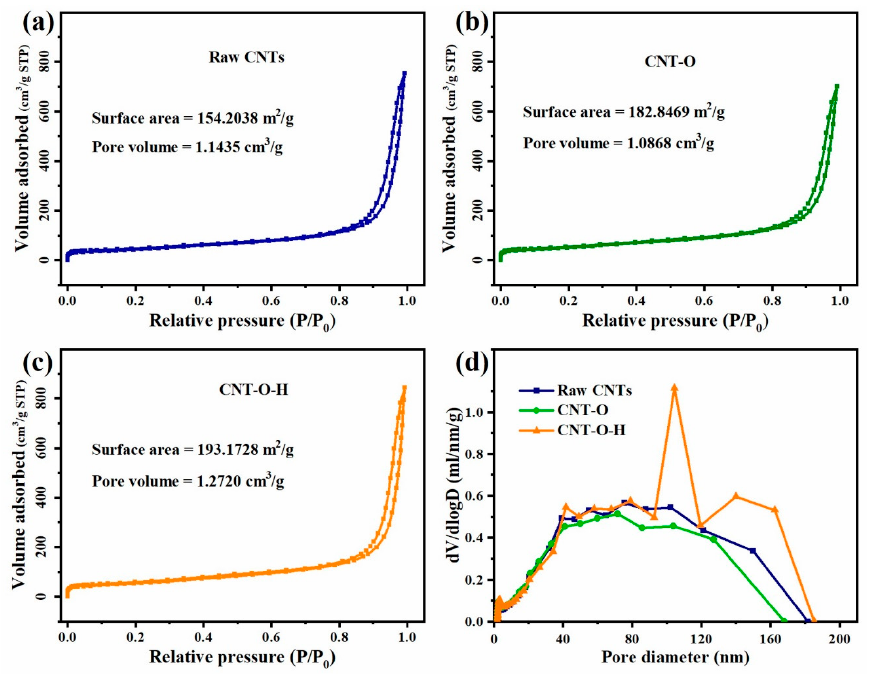
Figure 3. N 2 adsorption-desorption isotherms of raw CNTs ( a ), CNT-O ( b ), CNT-O-H ( c ), and pore size distributions ( d ). Nanomaterials 2023 , 13 , x FOR PEER REVIEW Further, XPS was employed to examine the surface chemical components of raw and modified CNTs. The high-resolution C 1s spectra of all CNTs (Figure S2) could be divided into four sub-peaks positioned at 286.9, 286.0, 285.5 and 284.7 eV, which could be allocated to C=O, C − O, C − C and C=C units, respectively [48,49]. In the O 1s XPS spectra (Figure 4a– c), the peak centered at 532.2 eV corresponded to the C=O bond while the peak located at 533.6 eV was assigned to the C − O bond [50]. Interestingly, the ratios of C=O/C − O changed during the treatment process. In comparison with raw CNTs, the ratio in CNT-O de- creased to 0.56 from 1.63, implying an increase of C − O groups, which was in agreement with the above FT-IR results. After calcination at 800 °C, the ratio in CNT-O-H conversely increased to 3.01, indicating a high C=O proportion in CNT-O-H. Considering that C=O could serve as active sites for persulfate activation [35], CNT-O-H with high C=O ratio was expected to possess high activity towards persulfate activation.